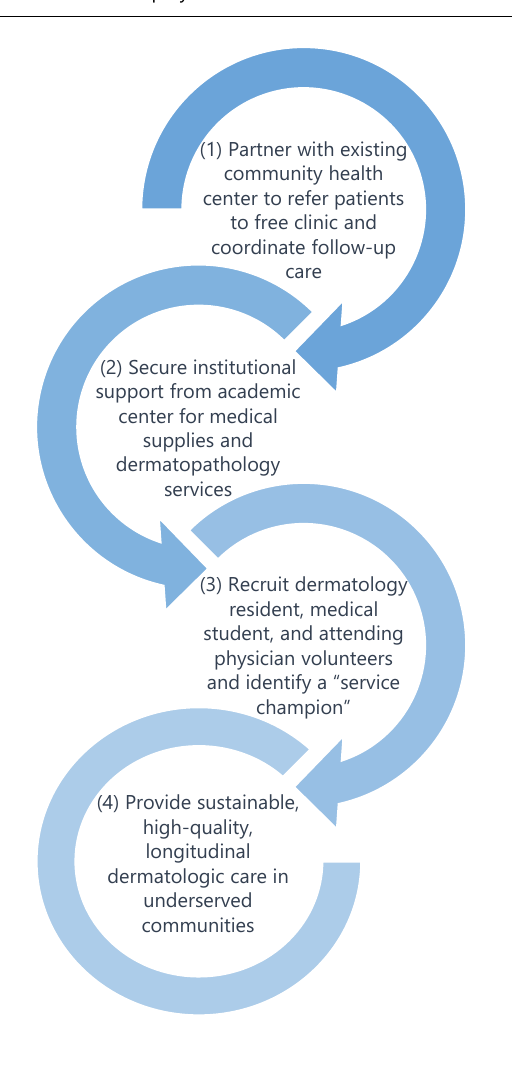
Figure 1. Sustainable Model of Academic-Community Partnerships Implemented by a Dermatology Residency Training Program to Promote Skin Health